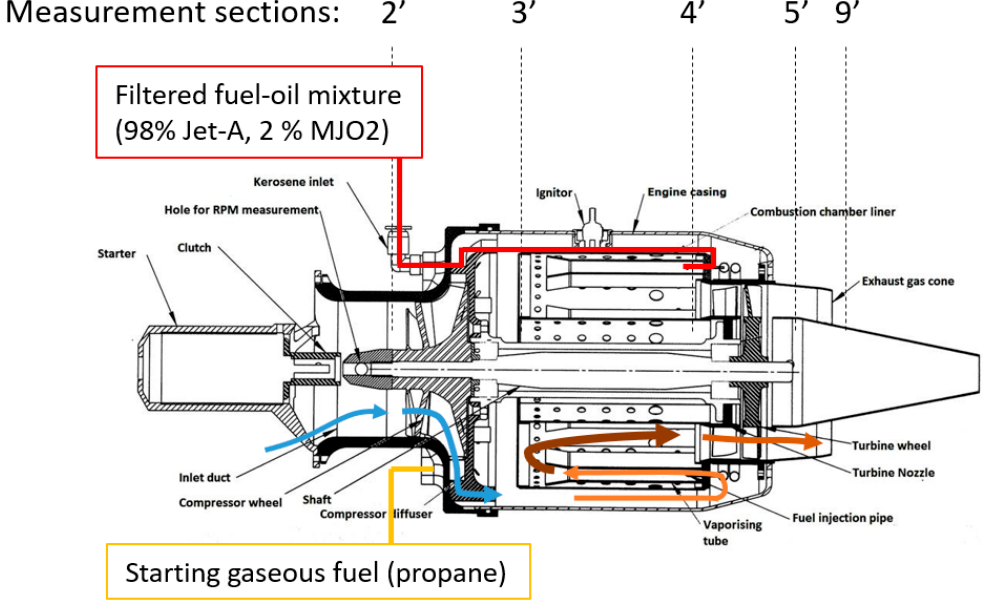
Figure 2. GTM-120 miniature gas turbine test stand (test stand no. 2) with main flow path (additional air is delivered through combustion chamber holes).